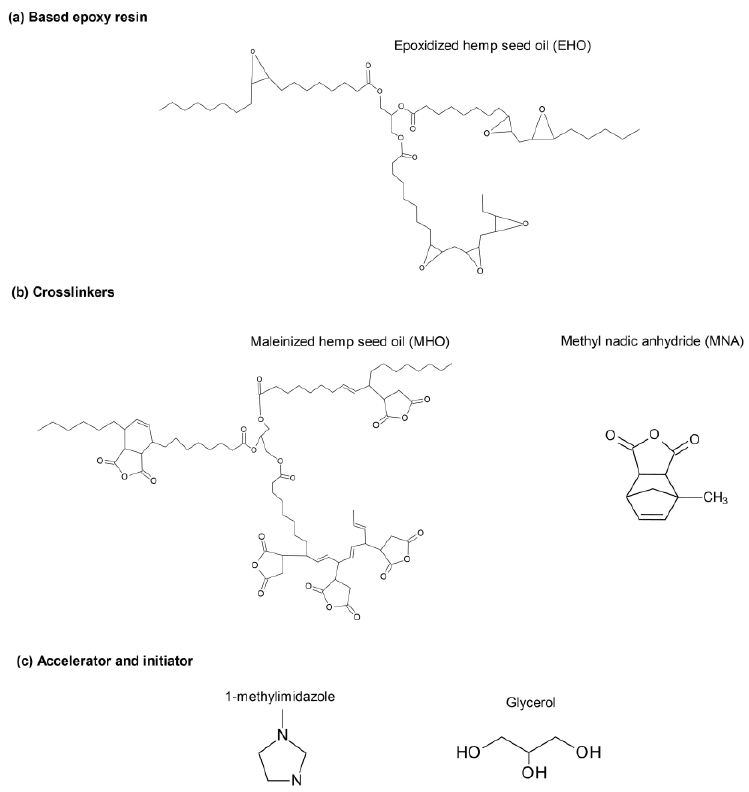
Figure 1. Chemical structures of the components used to obtain the final materials.